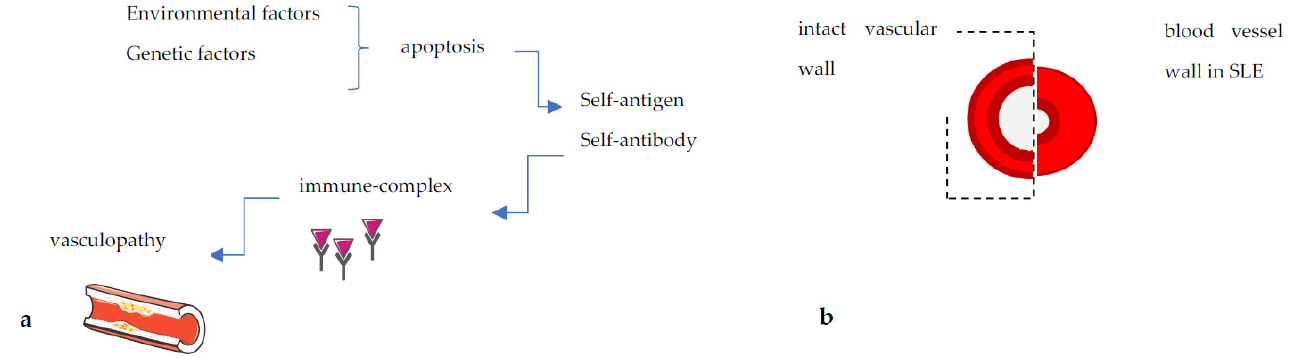
Figure 1. ( a ) Schematic pathophysiology of SLE leading to vasculopathy, including environmental and/or genetic dysregulations. ( b ) Vessel wall in patient with a SLE compared to the intact vascular wall.